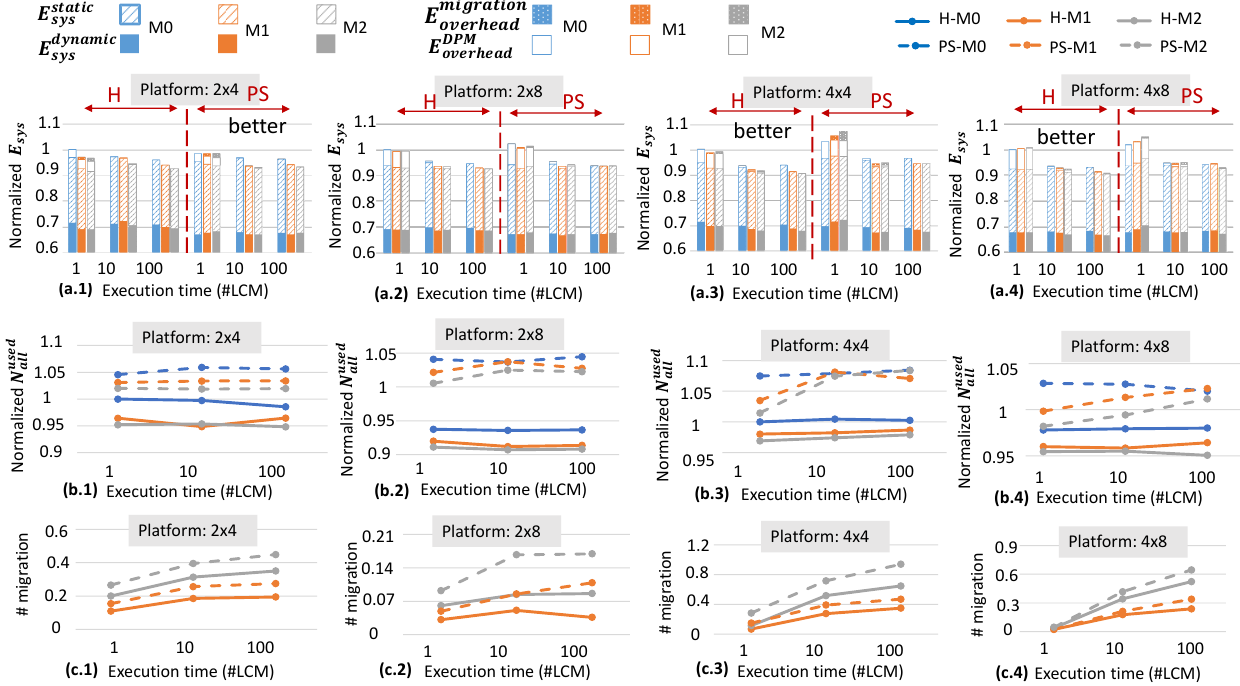
+ E migration Figure 7. ( a.1 – a.4 ) Normalized E sys (i.e., E dynamic sys + E static sys + E DPM , averaged in an overhead overhead LCM), ( b.1 – b.4 ) normalized N used (with regard to the holistic (H) strategy, #LCM = 1) and ( c.1 – c.4 ) all actual number of migrations in all common feasible use cases. Results are given for different management strategies, allowing 0,1,2 migrations, under constraints of increasing executing time (by using the Power static ∝ f 2 model), ( a.1 – a.4 ) normalized energy (averaged in an LCM) and for different platform sizes. Note : H: holistic strategy, PS: partially separate strategy, -M x : denoting a strategy allowing x migration(s) across